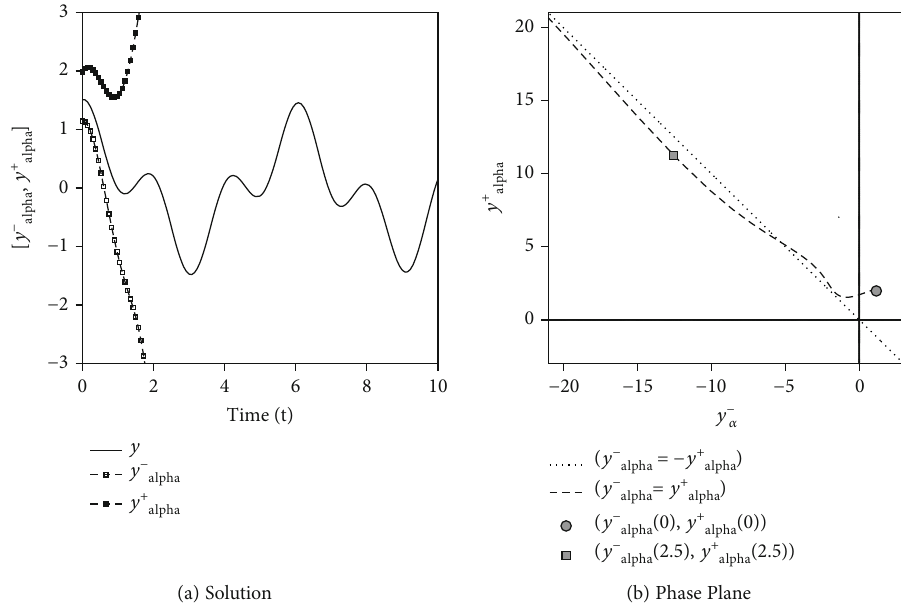
Figure 1: Solutions of Equation (23), the α − cut deterministic system which is obtained from applying the Hd concept. It is performed by using the extended RK method with the parameters which are in Equation (27) and the initial values which are in Equation (28). (a) The α − cut ½ y − , y + y − y + α α (cid:2) , with the left-end α is denoted by the no marked square, and the right one α by the black-marked square. In addition, the solid line states the approximation solution y of Equation (2), with a ð 0 Þ = γ ð 0 Þ = 1 [4]. (b) Phase plane ð y − α , y + α Þ , with y − α placed horizontally and y + α vertically. In addition, the black-marked cycle states coordinate point ð y − α ð 0 Þ , y + α ð 0 ÞÞ , the black-marked square states coordinate point ð y − α ð 2 : 5 Þ , y + α ð 2 : 5 ÞÞ , and the dotted line states equation y − α = − y + α